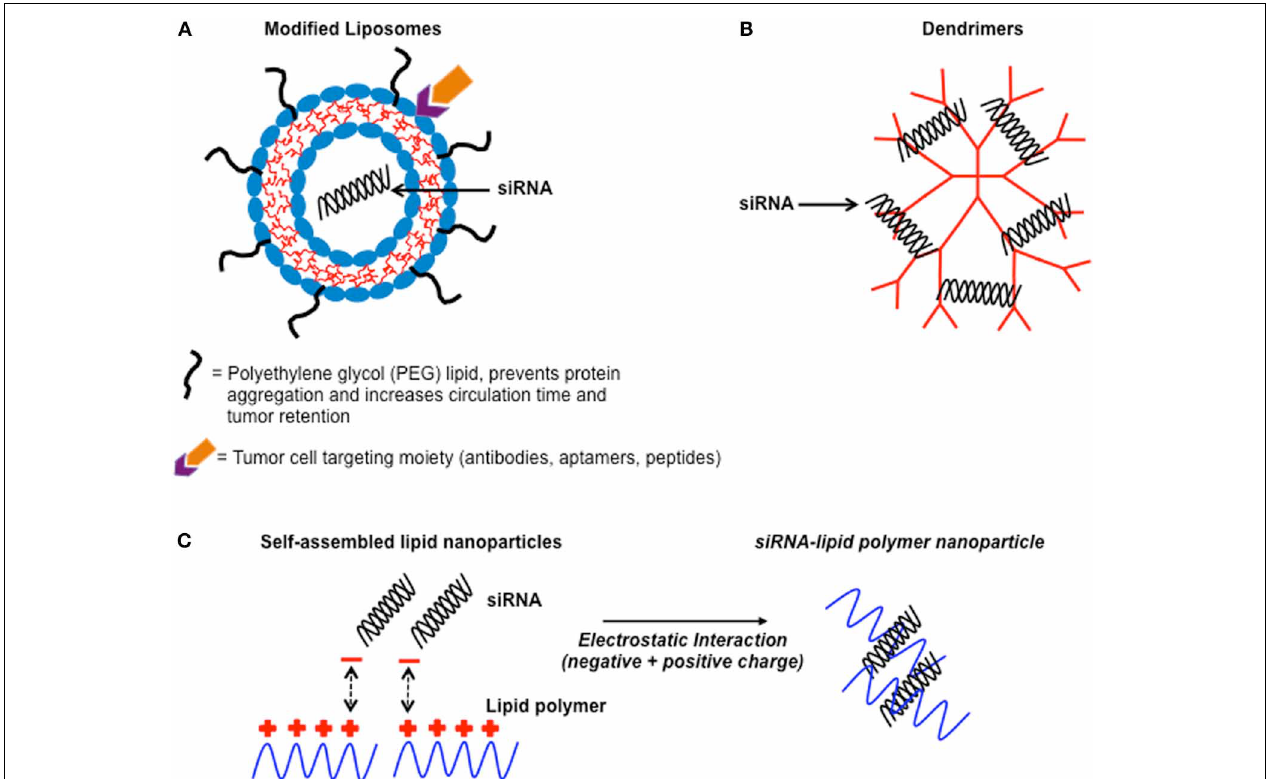
FIGURE 1 | Illustration showing some common non-viral nanoparticles used as delivery vehicles for siRNA. A schematic diagram of non-viral nanoparticle-siRNA delivery vehicles. (A) Liposomes which have been modified with PEG chains and contain active targeting moieties on their